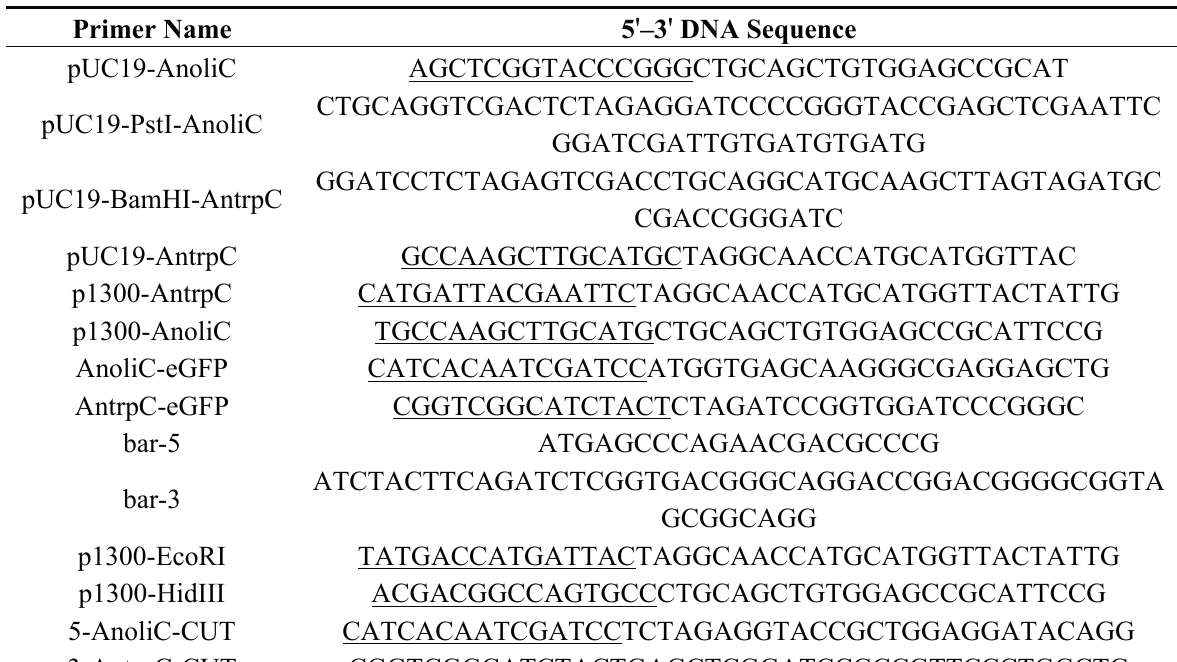
Table 1. The primers used in this study for vector construction, diagnostic PCR verification and RT-PCR